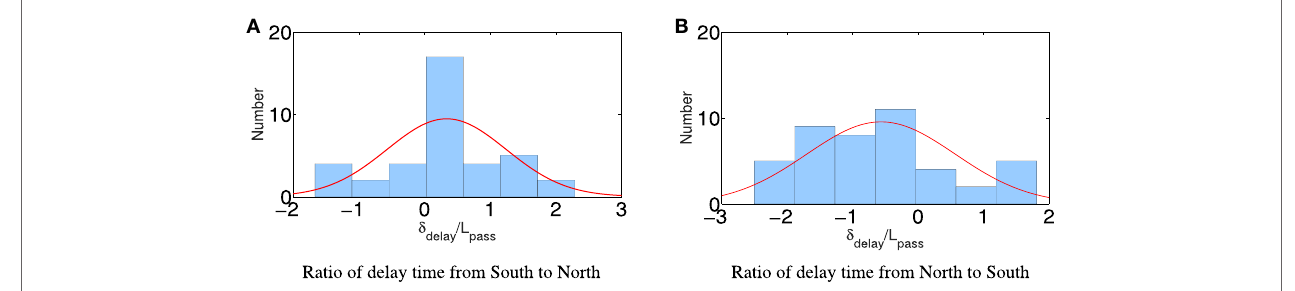
FIGURE 7 | The histogram of 82 cases’ ratio of delay time to total time of train passing, which is calculated by cross-correlation . Y-axis represents the number of cases, X-axis represents the ratio of delay time to total time length, and red line is the pdf curve of corresponding fitting normal distribution. (A) Ratio of delay time from South to North. (B) Ratio of delay time from North to South.